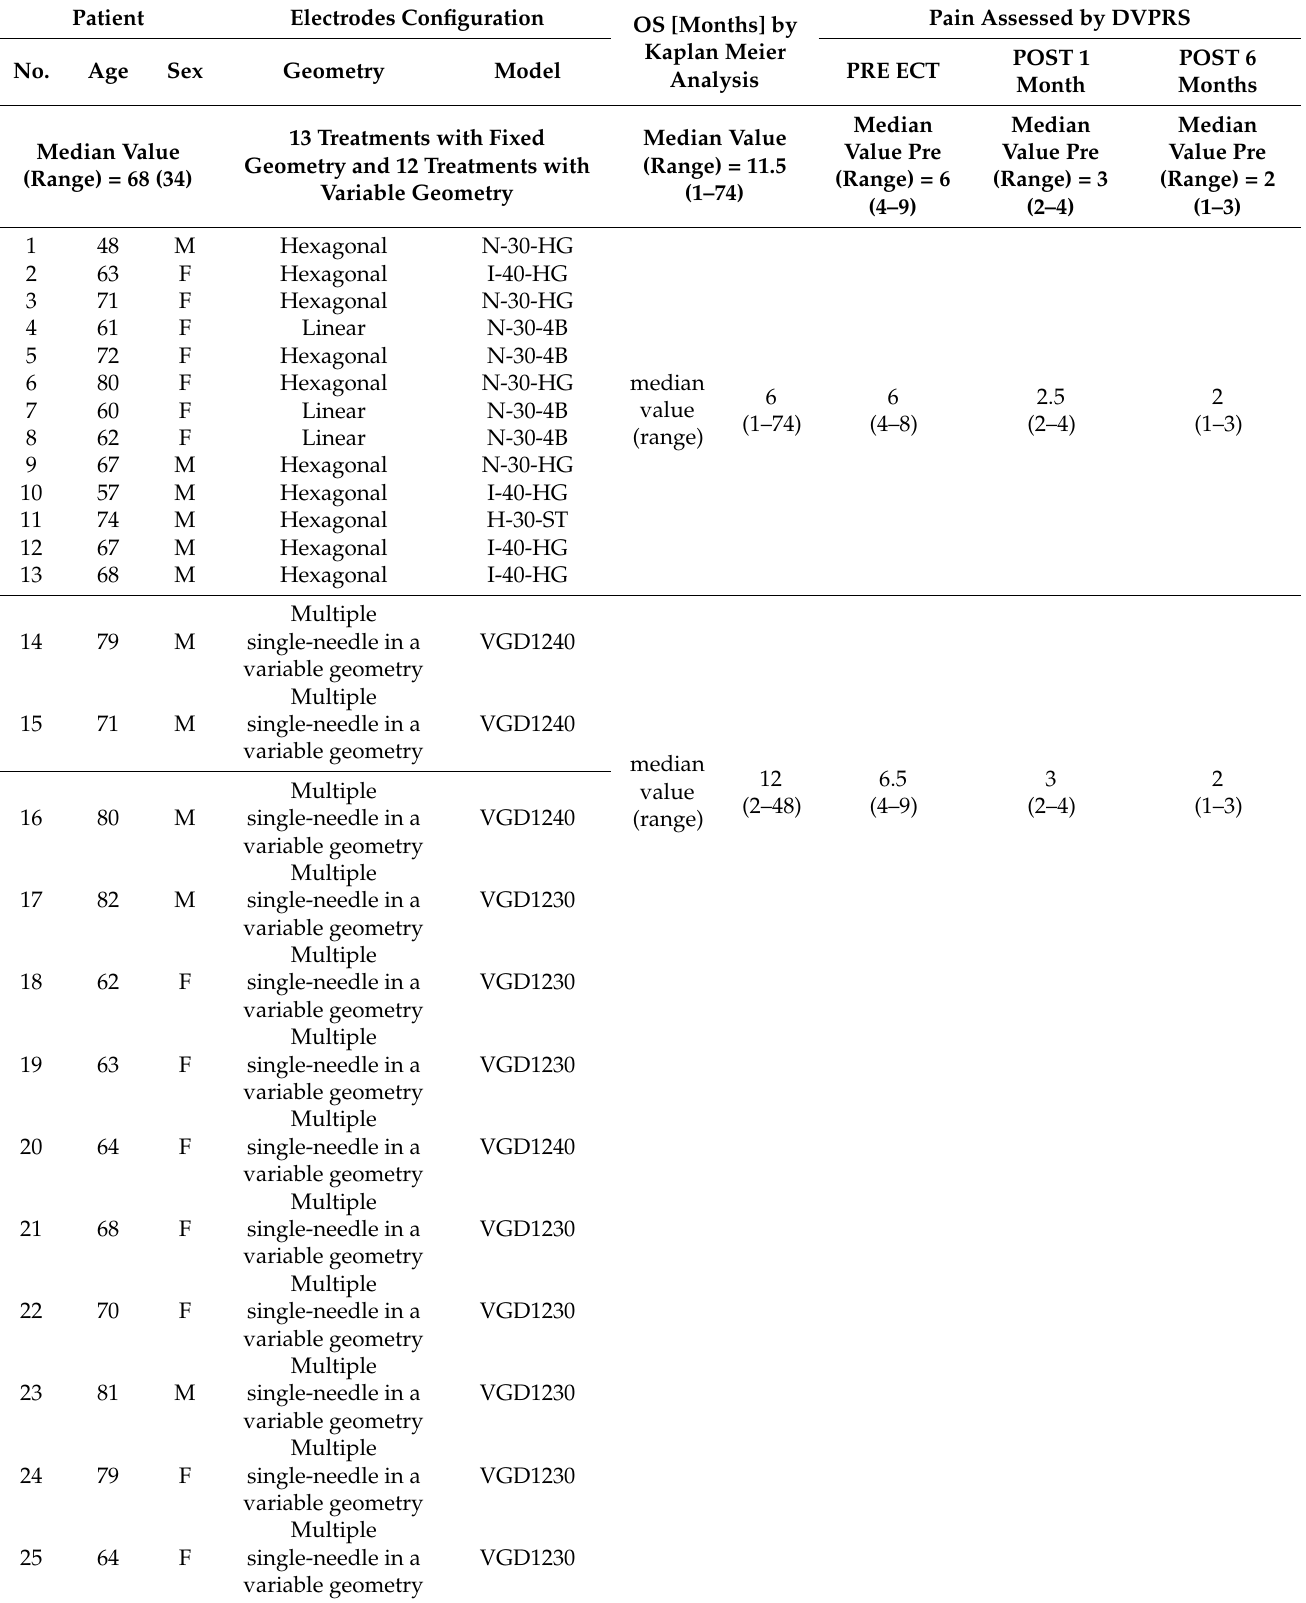
Table 2. Electrode configuration for each treatment and overall survival results in terms of median and range